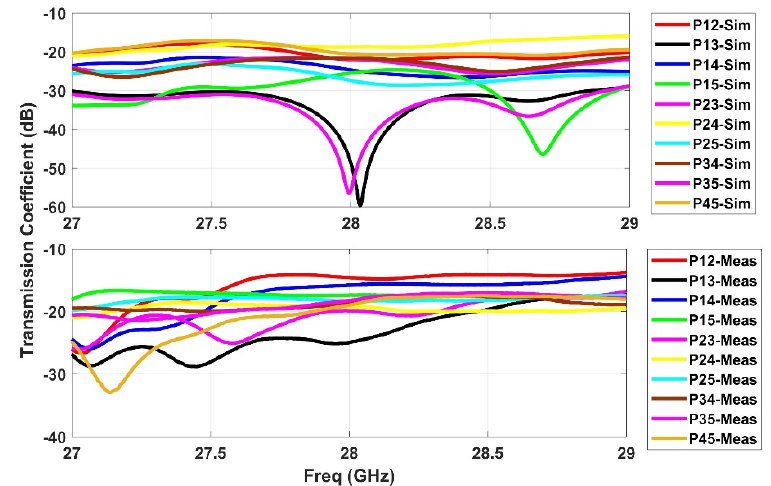
Figure 6. Simulated and measured s-parameters for the coupling among the beam ports (P1–P5).